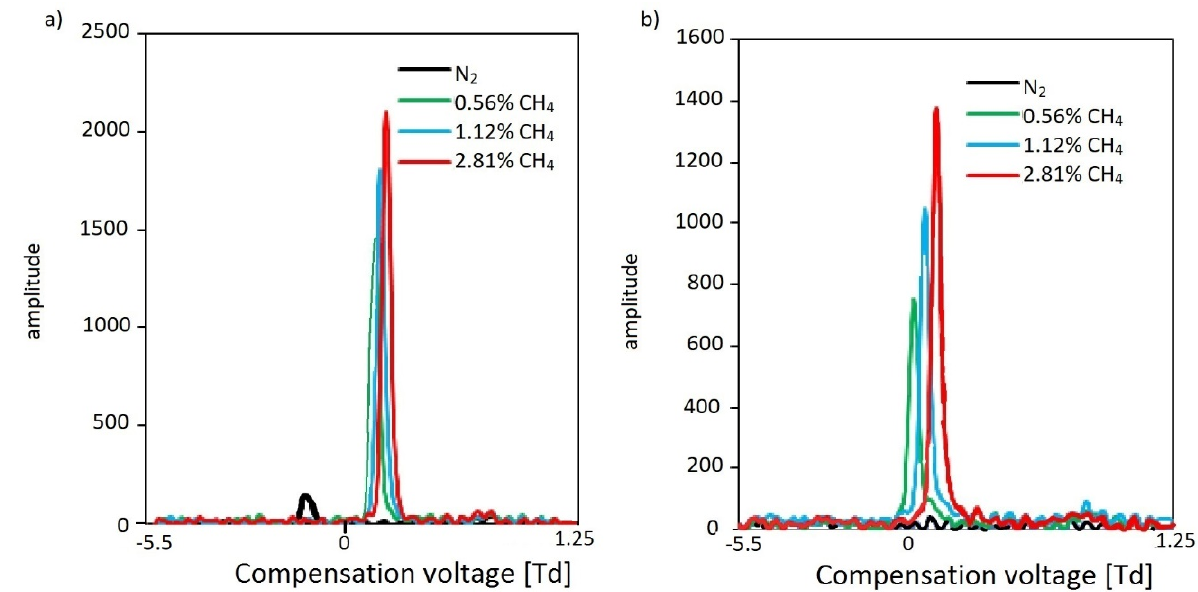
Figure 6. Differential mobility spectra for negative methane ions for SV voltage: ( a ) 115 Td; ( b ) 128